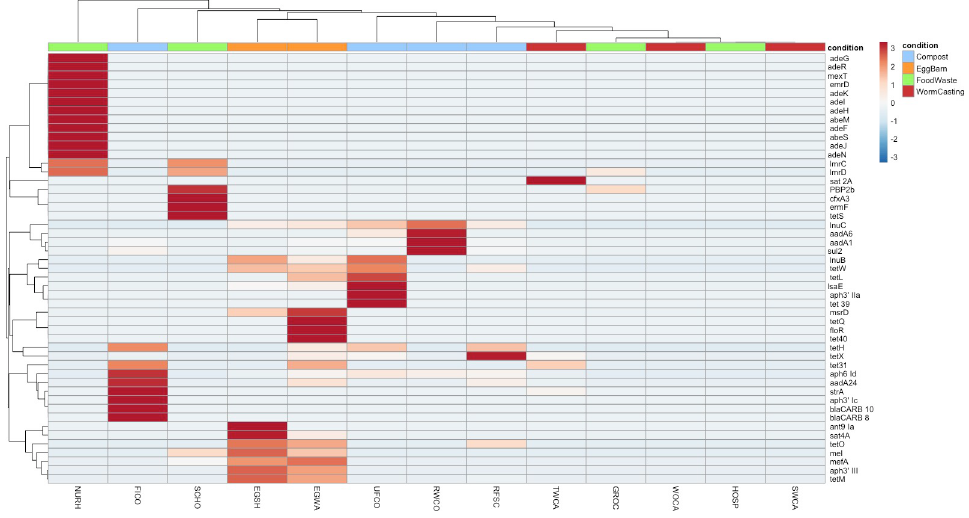
Fig 3. Heatmap displaying the differences in abundance ratio of ARGs between samples. Heatmap was scaled by row (individual ARGs) and created using the pheatmap package.